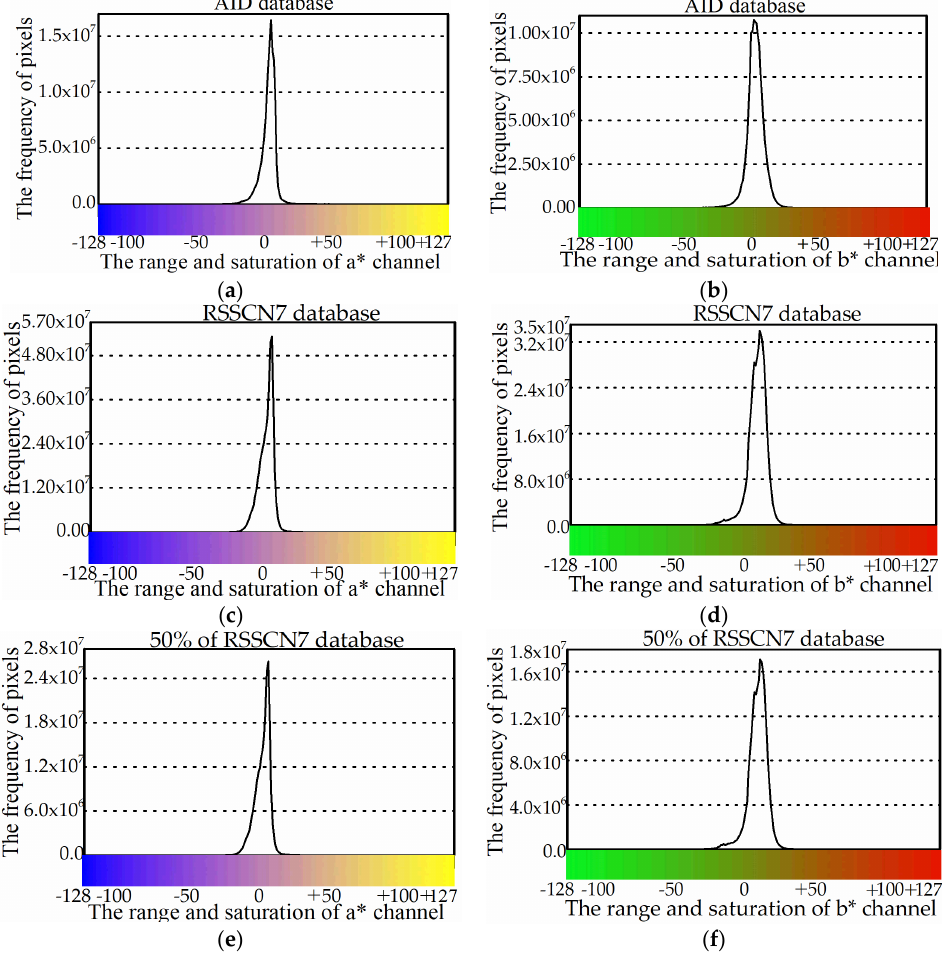
Figure 1. The frequency of pixels over different databases: ( a , b ) AID; ( c , d ) RSSCN7; and ( e , f ) 50% of RSSCN7.